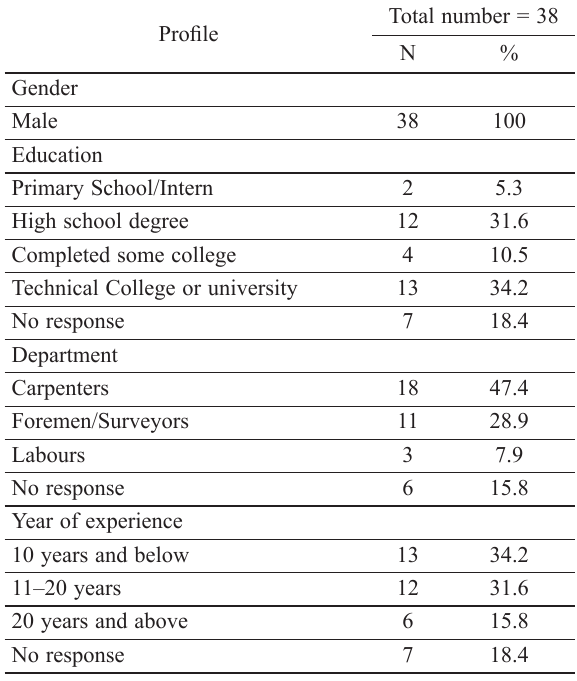
Table 1. Profile of respondents